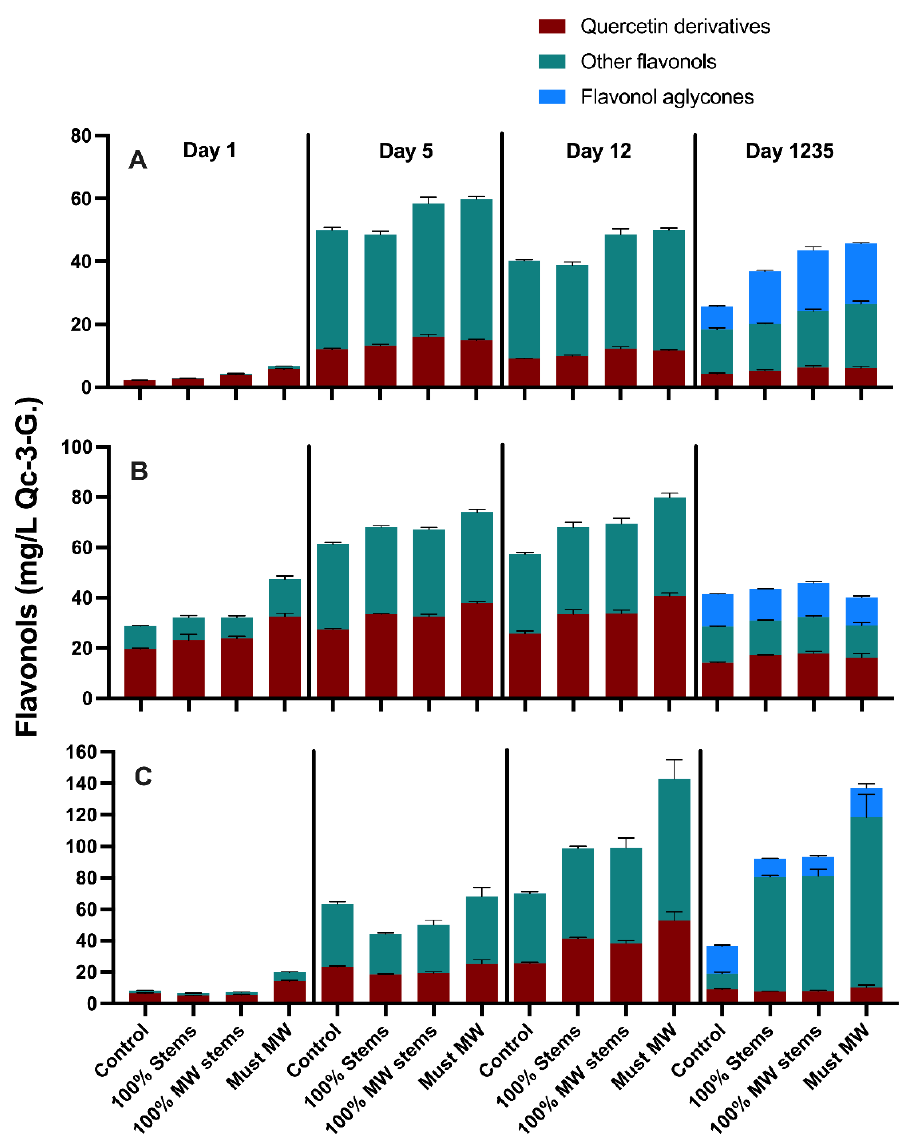
Figure 5. Evolution during winemaking and extended bottle aging (36 months) of quercetin derivates, other flavonols and flavonol aglycones. ( A ) Cabernet Sauvignon; ( B ) Merlot; ( C ) Syrah. Qc-3-G.: quercetin-3-glucoside equivalents.